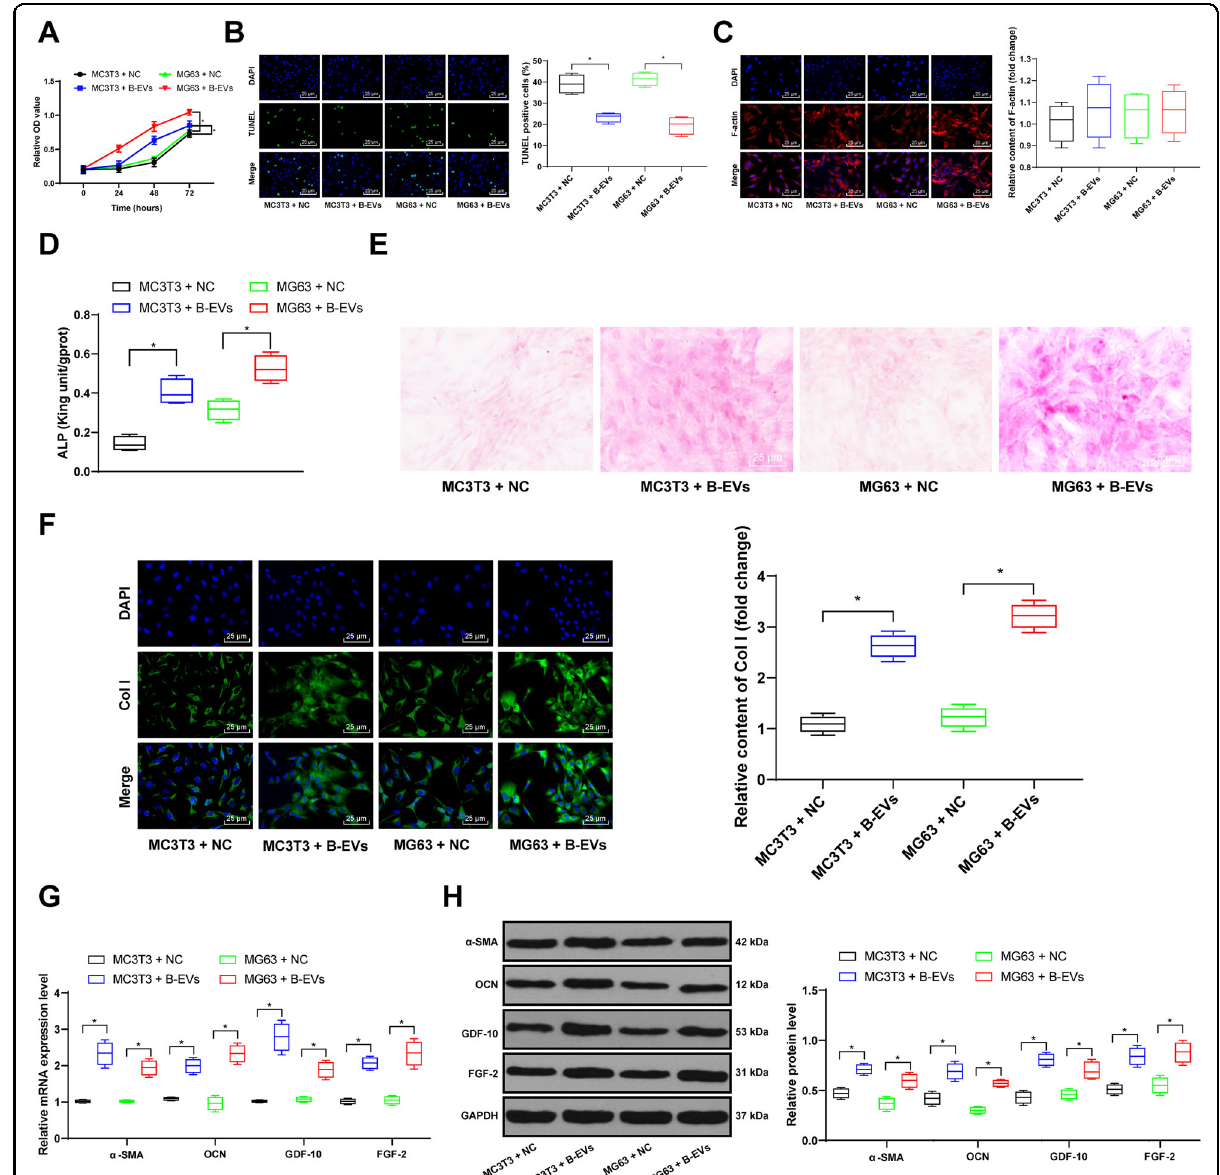
Fig. 4 B-EVs promote osteoblasts-like cell differentiation. The EVs were extracted from BMSCs and treated on MC3T3 and MG63 cells for 24 h, respectively. A MC3T3 and MG63 cell viability was determined by MTT assay. B TUNEL staining was performed to determine apoptosis of MC3T3 and MG63 cells. C Immuno fl uorescence staining measured the expression of F-actin in cells. D ALP activity in MC3T3 and MG63 cells was determined by ALP assay. E Alizarin red staining was performed to validate MC3T3 and MG63 bone differentiation ability. F Immuno fl uorescence staining measured the expression of Col I in cells. G , H RT-qPCR and western blot analysis were performed to determine mRNA and protein levels of α -SMA, OCN, GDF- 10, and FGF-2. Data are expressed as mean ± standard deviation. Two-way ANOVA and Tukey ’ s multiple comparisons test were used to determine statistical signi fi cance. * p < 0.05. Four independent experiments were